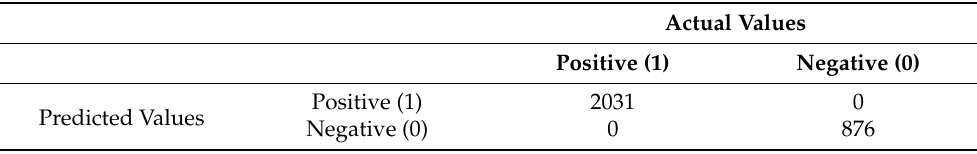
Table 10. Support vector classifier confusion matrix.